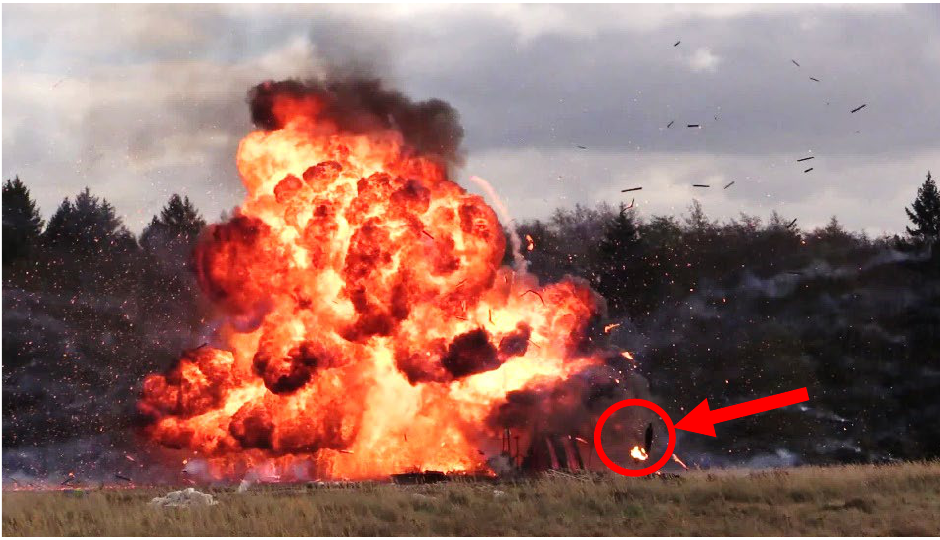
Figure 7. Uncontrolled destruction of acetylene cylinder (fireball).